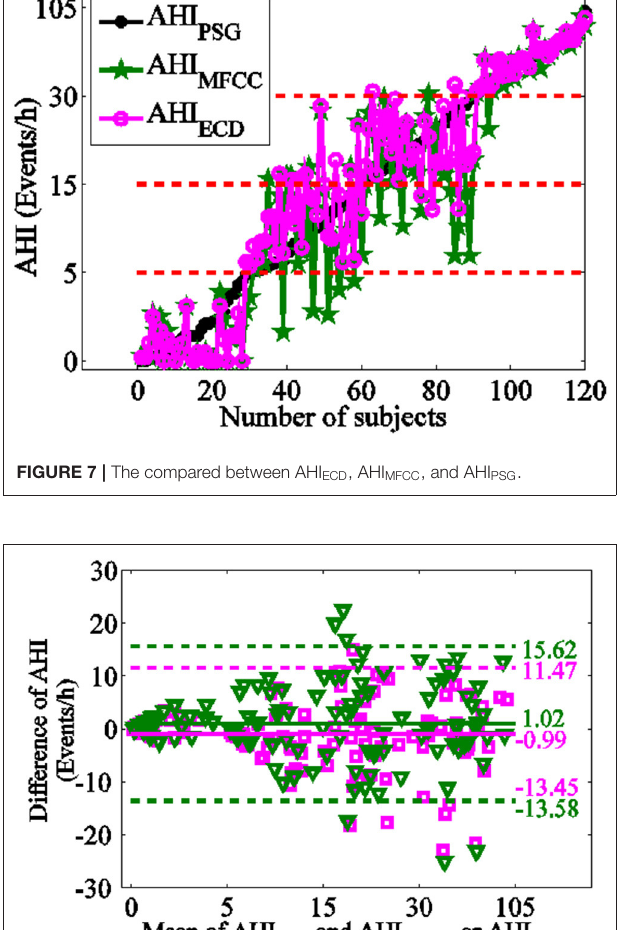
change component increases. The Fourier transform shows a characteristic of global decline and local prominence. Compared with MFCC, the ERB enlarged partially and highlighted the anomaly of the mid and high frequency